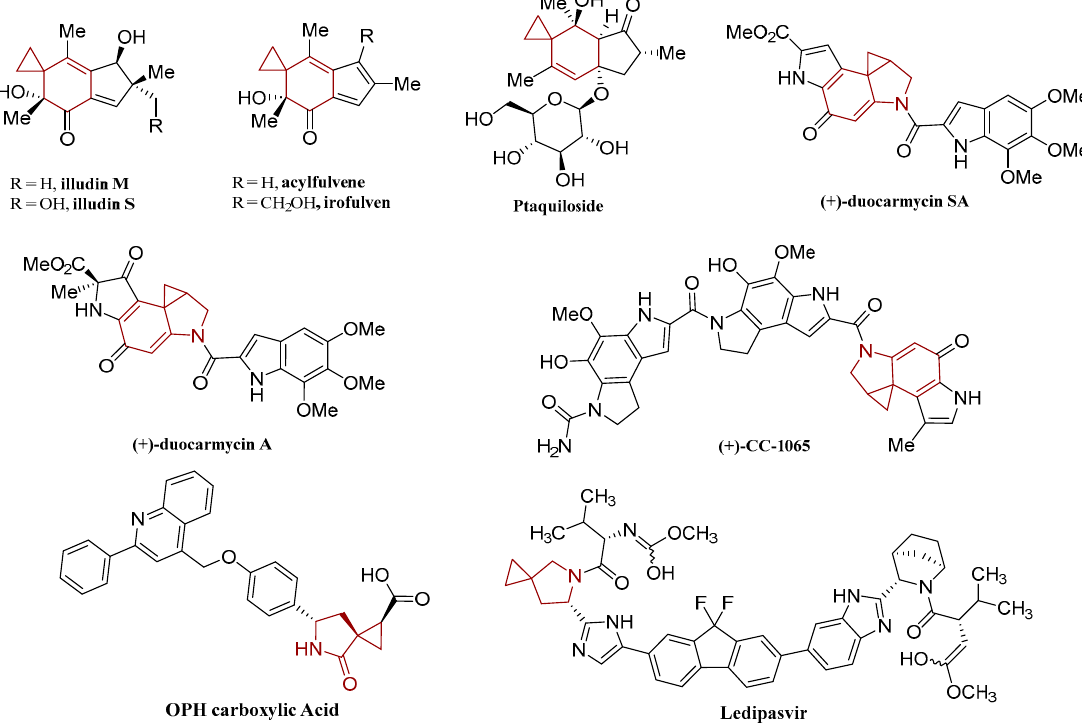
Figure 1. Selected products containing spirocyclopropanane possess biological activities.